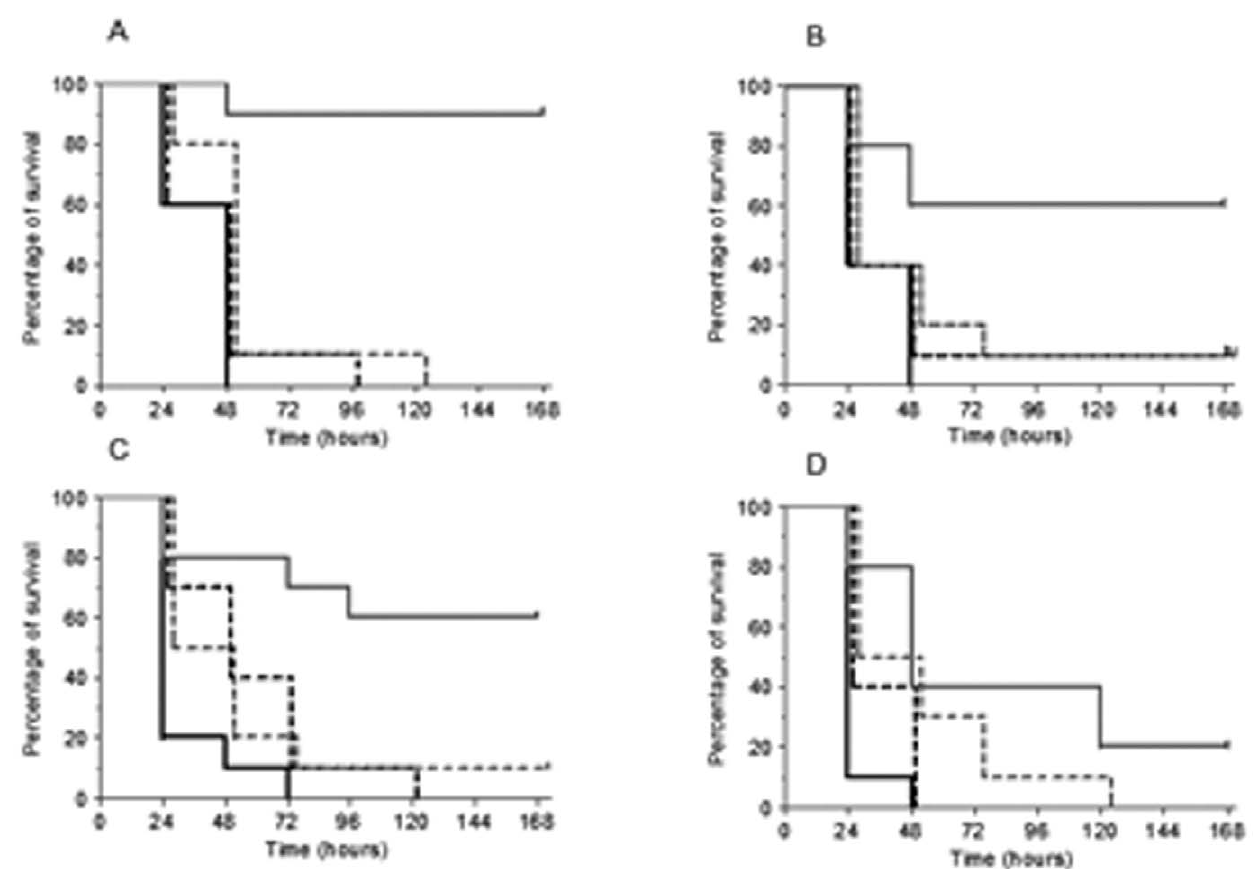
Figure 3. Therapeutic efficacy. Survival curves. Lines: continuous black (control), dotted black (antibiotic non-protective dose; A-np), dotted grey (hyperimmune serum non-protective dilution; HS-np) and continuous grey (A-np treatment in animals pre-immunized with HS-np). (A) Strain 1 (A-np: 12.5 mg/kg; HS-np=1/4), (B) Strain 3 (A-np: 50 mg/kg; HS-np=1/2), (C) Strain 2 with cefditoren (A-np: 50 mg/kg; HS-np=1/4), and (D) Strain 2 with ceftriaxone (A-np: 6.25 mg/kg; HS-np=1/4).